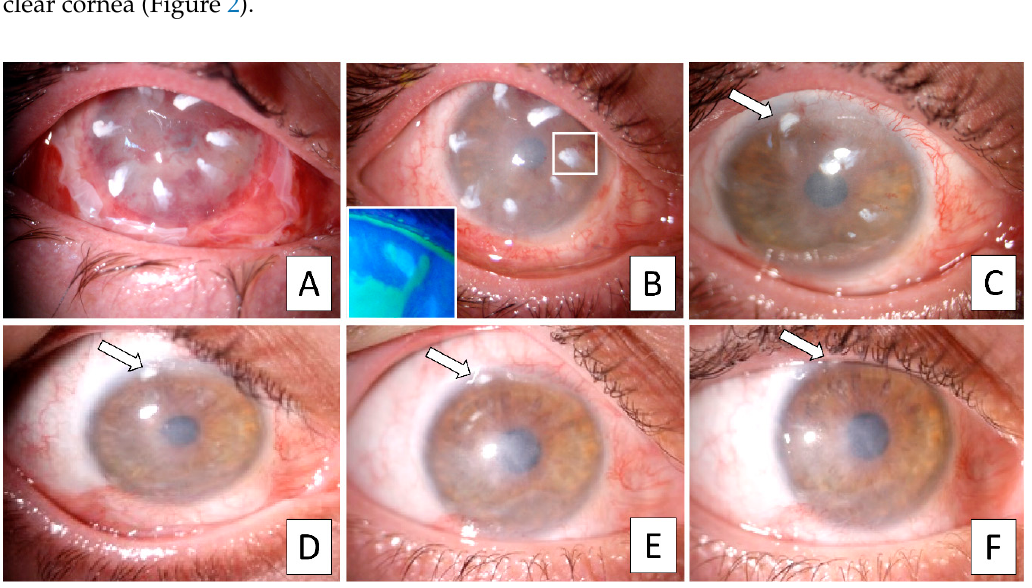
Figure 2. Longitudinal slit lamp biomicroscopy indicating the progressive disappearance of limbal biopsy fragments after Simple Limbal Epithelial Transplantation (SLET). ( A ) At one week after SLET, the amniotic membrane (AM) and the limbal biopsy fragments are evident; ( B ) after one month, the AM is completely resorbed and the limbal biopsy fragments present more indistinct margins; the epithelial growth from the limbal biopsy fragment is distinguishable as unstained epithelium in the context of stained AM (cobalt blue light after fluorescein staining, bottom left); ( C ) at 2-months, few reduced-sized fragments are still visible; ( D – F ) from 3, 6, and 12 months, respectively, no limbal biopsy fragments were detectable on the clear cornea. Notably a fragment on the peripheral supero-temporal area persisted ( F , arrows), likely following its integration within the limbo-scleral tissue (representative results from patient no. 10).